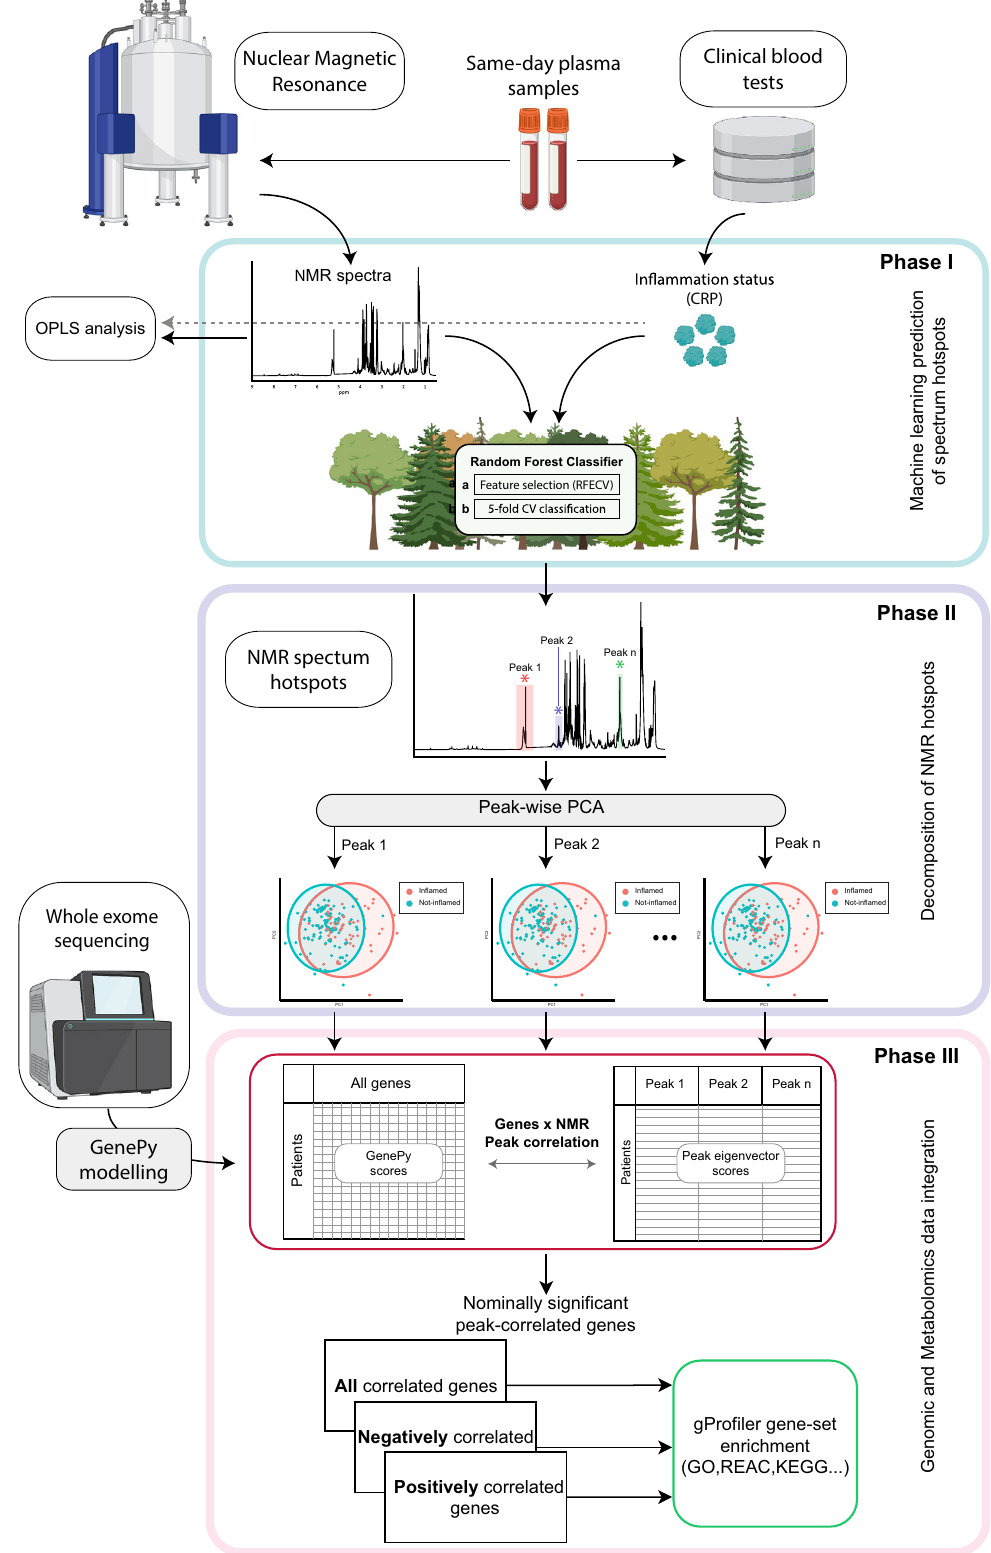
Figure 1. NMR and genomic data integration. Phase (I) NMR spectra and patient CRP data were input to the RF model using (a) RFECV and (b) cross-validated methods to select spectral regions discriminating non/ inflamed patients. Phase (II) Informative data-points were clustered and peaks reduced to a single eigenvector. Phase (III) Eigenvectors for each peak were individually correlated against all genes and tested for enrichment. Created with